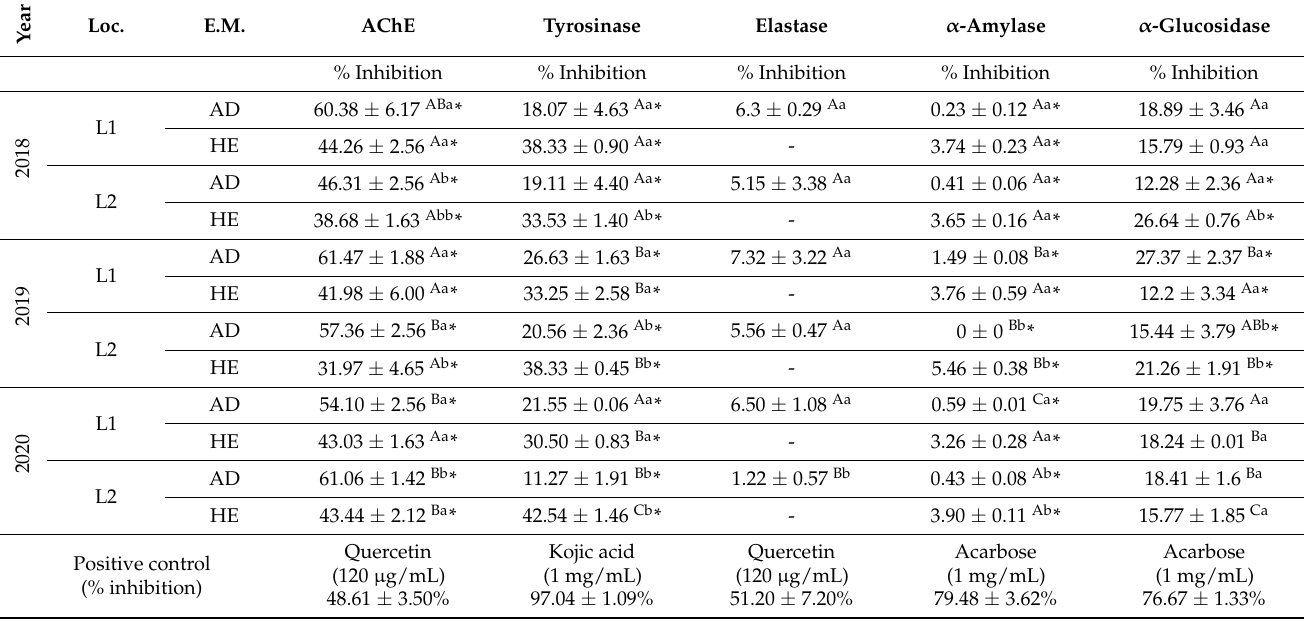
Table 3. Assessment of T. carnosus extracts neuroprotective, anti-aging, and anti-diabetic potential evaluated as target enzymatic